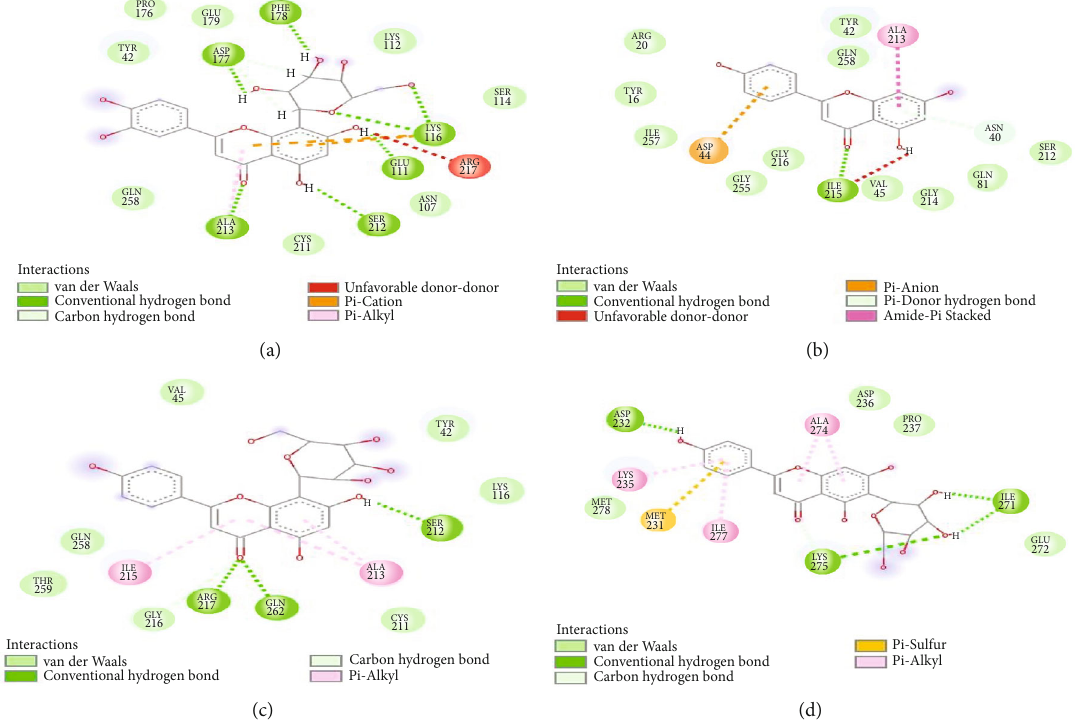
Figure 2: Interaction types and plots of (a) orientin, (b) apigenin, (c) vitexin, and (d) ursolic acid towards protein tyrosine phosphatase 1B (PTP1B) after 100 ns MD